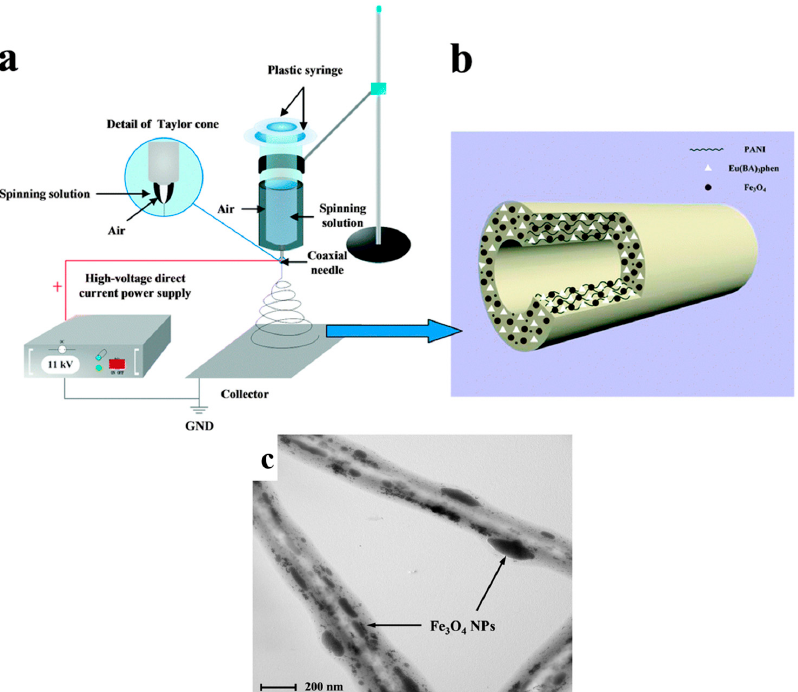
Figure 9. ( a ) The schematic shows details of the one-pot coaxial electrospinning process and set-up; ( b ) the schematic of the as-synthesized hollow nanofibers containing the europium complex, PANI, and Fe 3 O 4 nanoparticles; ( c ) TEM image of the Eu(BA) 3 phen/PANI/Fe 3 O 4 /PVP hollow nanofibers (Reproduced with permission from [148]. Royal Society of Chemistry, 2017).